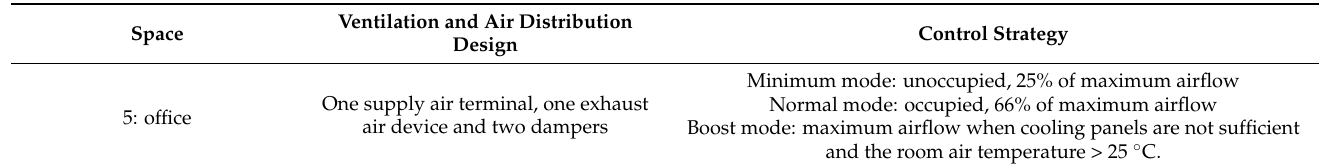
Table 4. Ventilation and air distribution design and control strategies for Type 2 space.